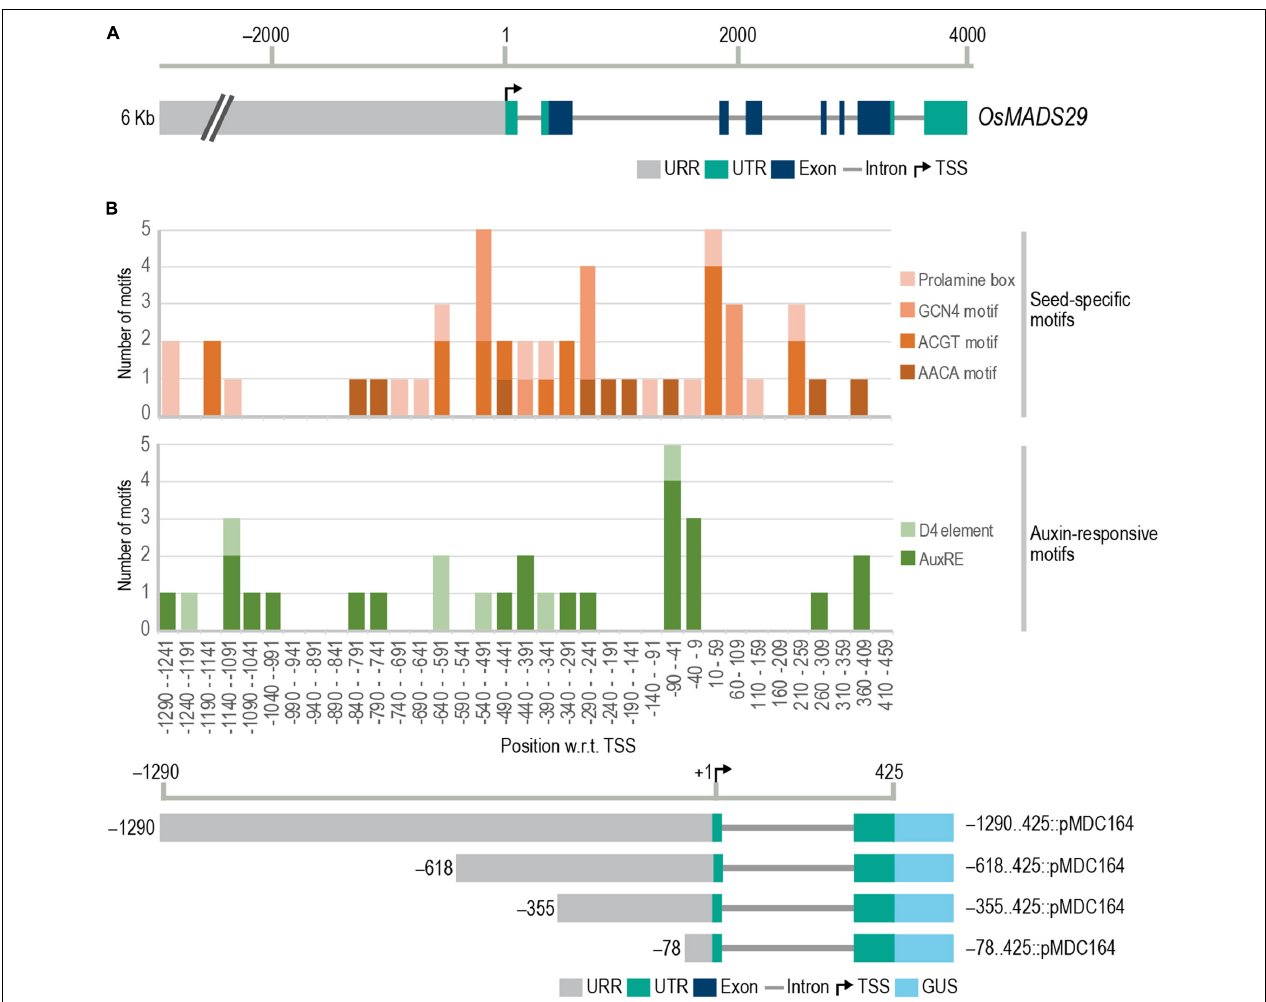
FIGURE 1 | Gene structure of M29 and frequency distribution of conserved cis -elements in M29 URR. (A) Gene structure of M29 and its upstream region (chr02:3843135.3833130). (B) Frequency distribution of conserved seed-specific and auxin-responsive cis -elements in the M29 URR between –1,290 and 425 nt. In (B) , the Y -axis represents the number of motifs, and the X -axis represents 50 bp intervals of the M29 URR from –1,290 to − 459 and at the bottom, a diagrammatic representation of the four deletions of the M29 URR in the pMDC164 vector showing the 5 (cid:48) and 3 (cid:48) boundaries of each construct fused with the GUS reporter. Motifs were predicted using the PLACE database motif list in CLC Main Workbench version 20.0.4 and plotted using a stacked column graph in Microsoft